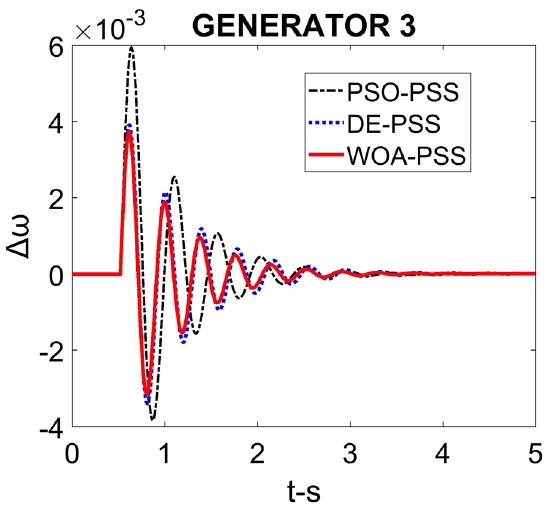
Fig. 12 Speed deviation of G3 for 10% step change at turbine input